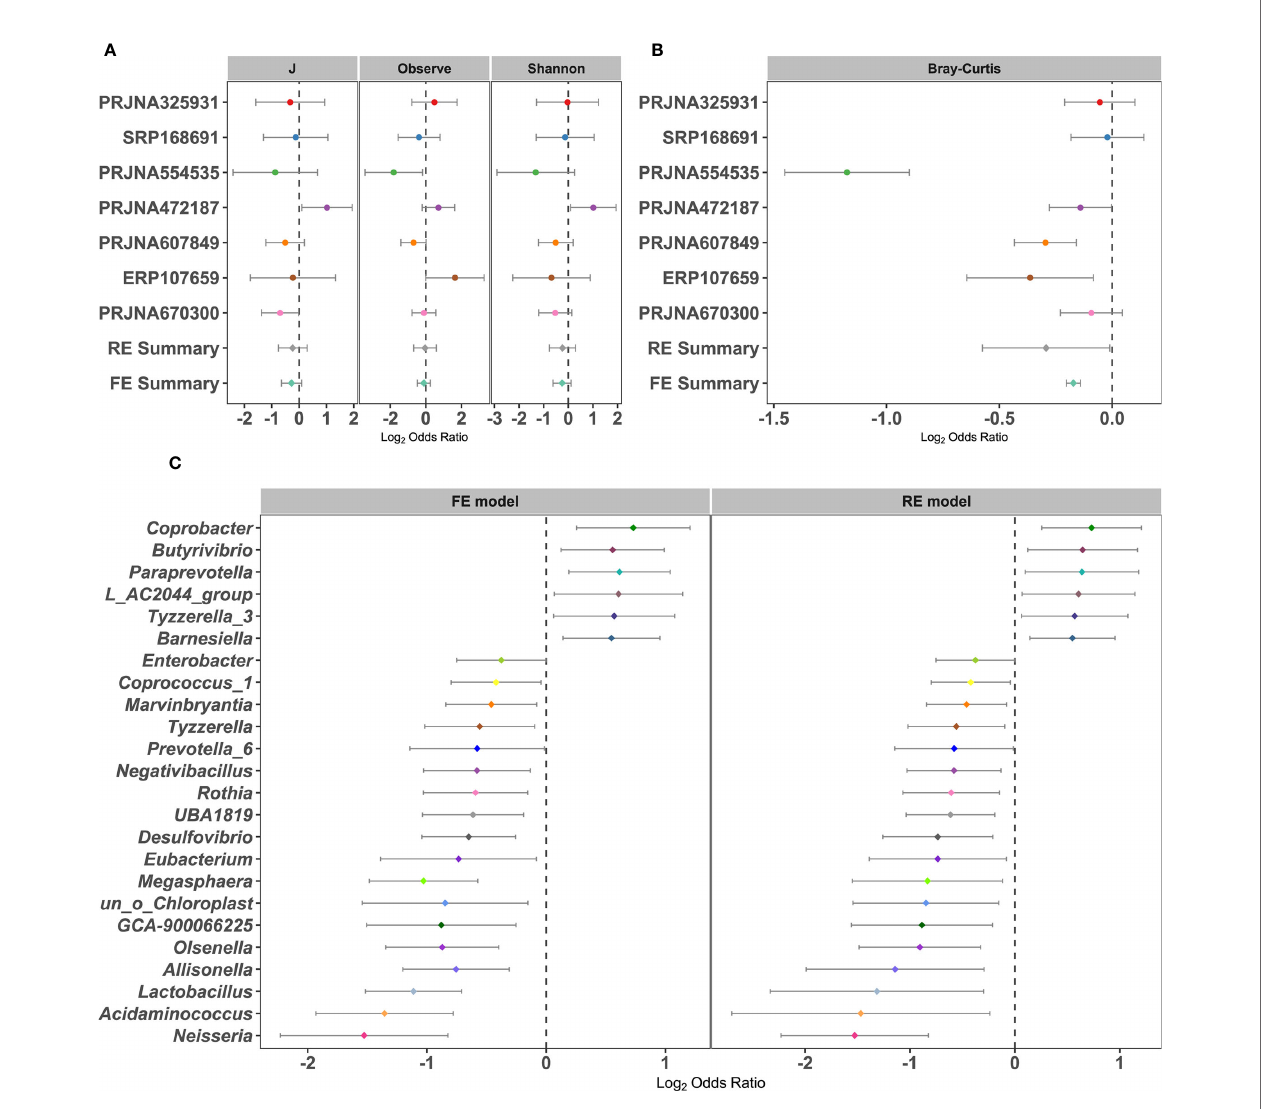
FIGURE 2 | Forest plot of (A) the alpha diversity metrics and (B) Bray-Cutris distances between the individual with diabetics and the controls and (C) the genus metrics (Among them, the full name of L_AC2044_group is Lachnospiraceae_AC2044_group ). The error bar depicts the 95% con fi dence interval. The value less than 1.0 (left side of the dashed line) depicts that the metric is higher in T2DM than the control. The values bigger than 1.0 (right side of the dashed lines) depicts that the metric is lower in T2DM than the control. There were signi fi cantly difference between the case and the control, if there was no cross between the dashed line and the error